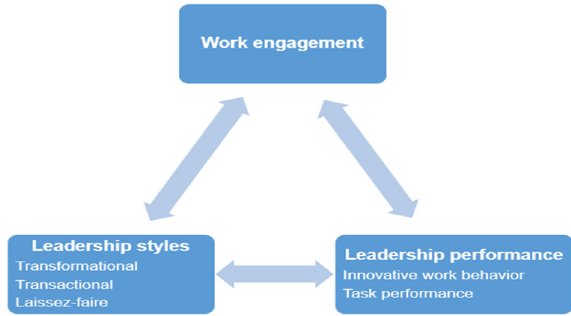
Fig. 1 Research model of the three variables. The relationship